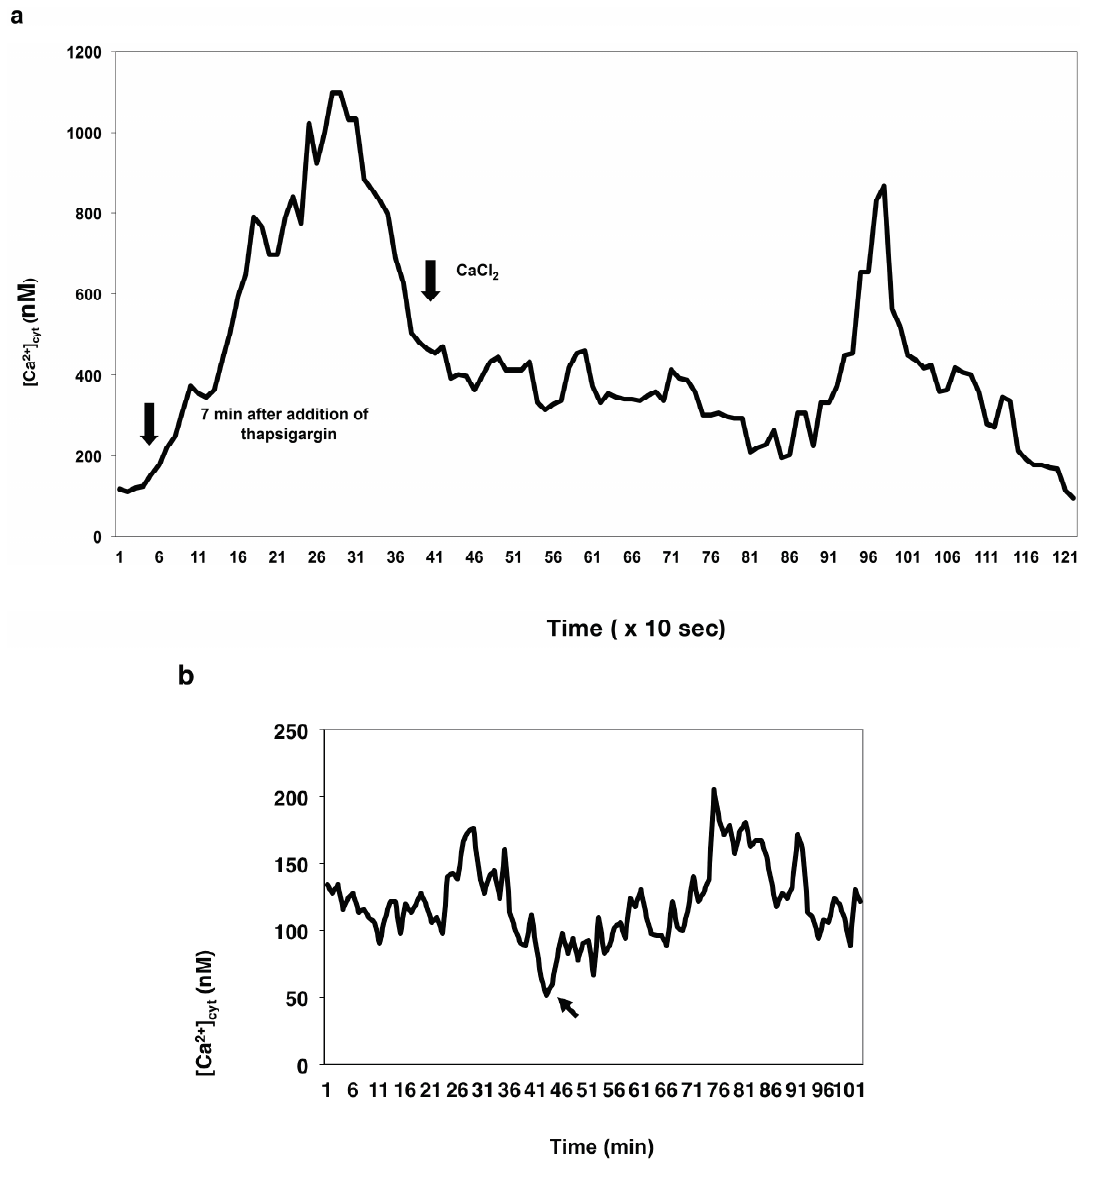
Figure 10. Thapsigargin treatment of isolated wheat egg cells hints at the involvement of an intracellular calcium store in the calcium release mechanism triggered by sperm fusion. ( a ) Thapsigargin activates divalent cation entry in wheat female gametoplasts. The graph represents the change in [Ca 2+ ] cyt in an unfertilized wheat egg incubated in thapsigargin in Ca 2+ -free isolation medium followed by the addition of 2 mM CaCl 2 ; ( b ) In the control experiment shown, no discernable change was observed in [Ca 2+ ] cyt over a 60-min period when 2 mM CaCl 2 was added to control eggs not previously treated with thapsigargin. The arrow shows the time when thapsigargin was added to the